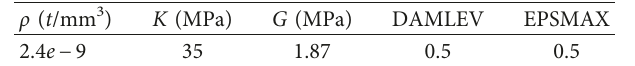
Figure 6: Stress-strain curve of AA6060-T4. Table 2: Material parameters of